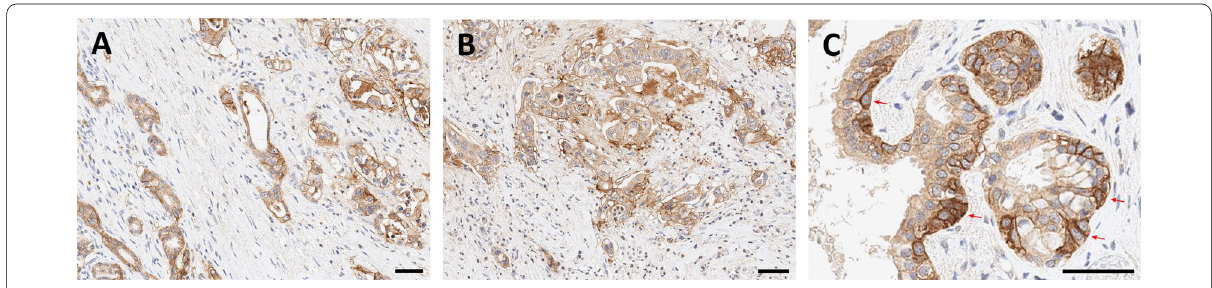
Fig. 3 β6-integrin immunohistochemistry of a non-metastatic pancreatic ductal adenocarcinoma (PDAC) localized in the pancreatic tail. Bars indicate 50 µm. The integrin is expressed by most tumor cells ( A ), and a substantial higher expression is observed in the infiltration margin ( B ). Invading tumor cells directly adjacent to the surrounding stroma (examples indicated by arrows) regularly show intense upregulation of β6-integrin expression ( C ). Note that the β6-subunit dimerizes only with the ubiquitous αv (see Fig. 1), which is why β6-IHC is indicative for actual αvβ6